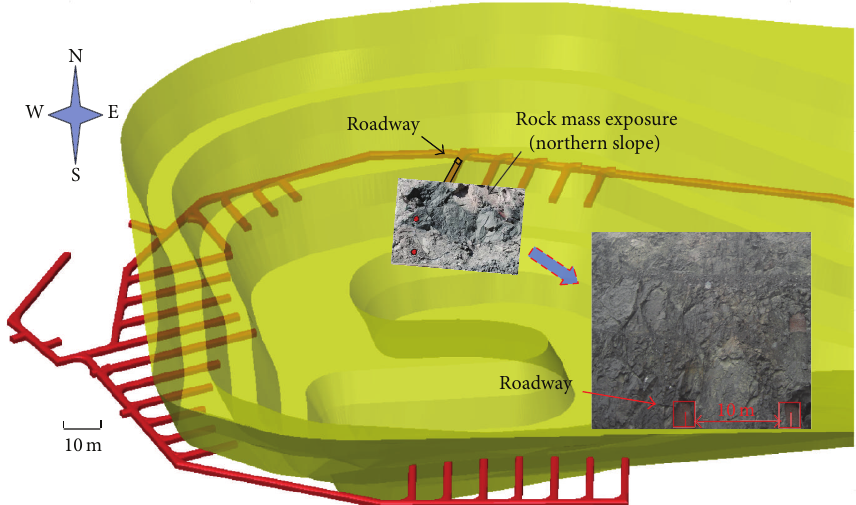
Figure 8: The rock mass exposure of northern slope in Heishan open pit